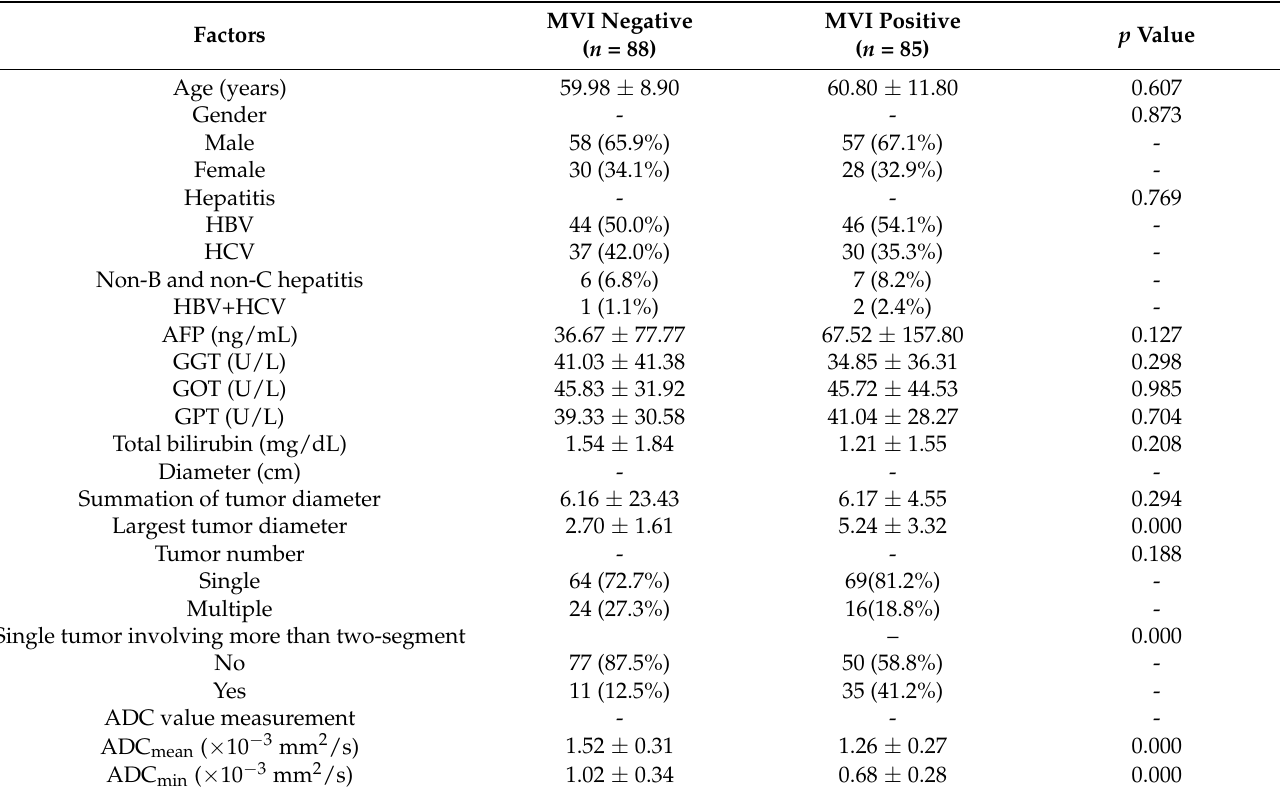
Table 2. The predictive factors for the MVI of HCCs based on right lobe